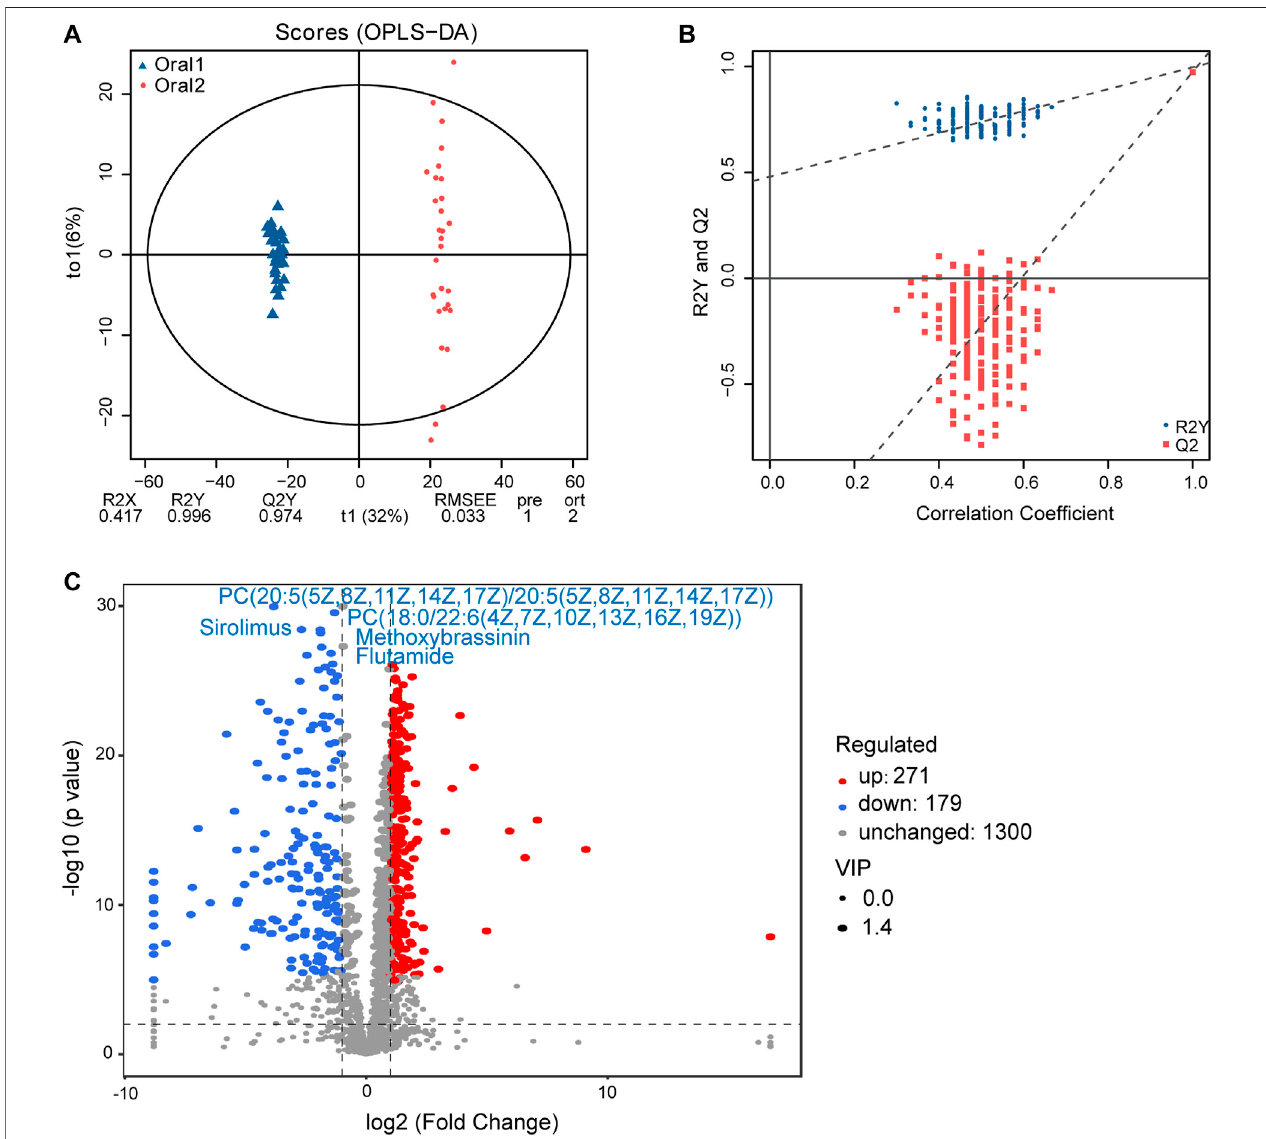
FIGURE 4 | Circulating metabolomics for the quanti fi cation of metabolites in the before- and after-administration groups. (A) OPLS-DA plots showing the spatial divisionbetweenthebefore-andafter-LScapsuleadministrationgroups. (B) PermutationplotsofOPLS-DAmodelscorrelationcoef fi cient. (C) Volcanoplotshowingthe differentially accumulated [log2 (fold-change) on x -axis] and signi fi cantly changed [ – log10 ( p value) on y -axis] metabolites in the before- and after-administration groups.